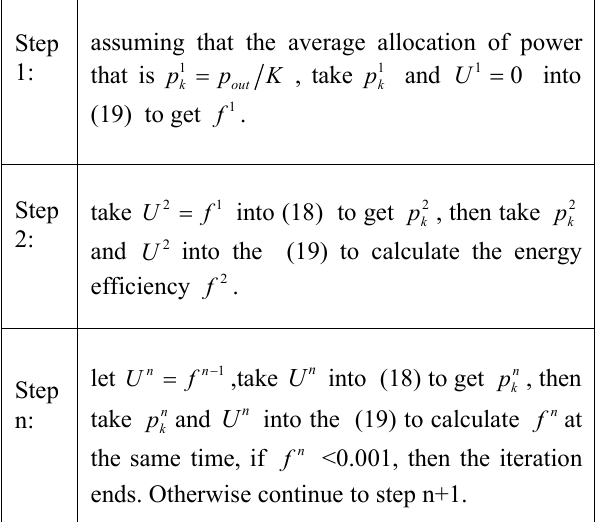
Table 1. An iterative power allocation algorithm